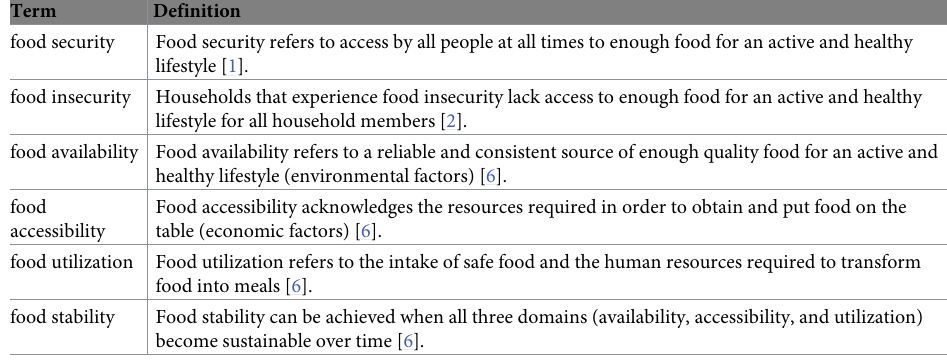
Table 1. Glossary of food security